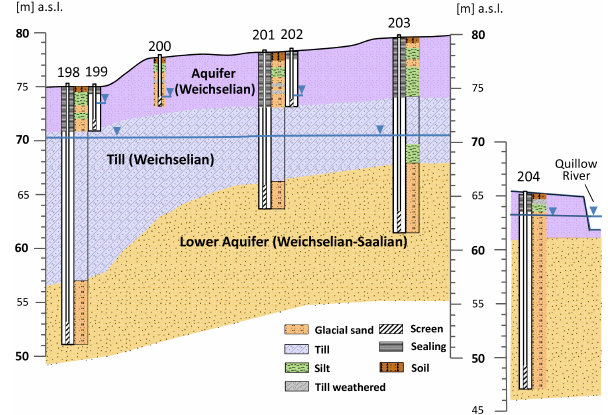
Figure 4. Hydrogeological and technical logs of each installed GW well, including the main stratigraphic units, screen positions and